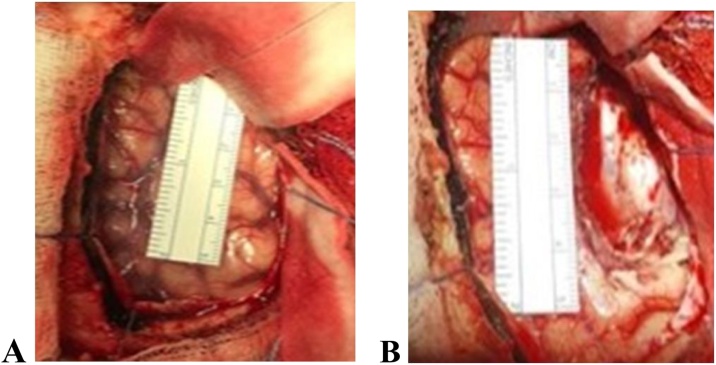
Intra-operative pictures showing the extent of neocortical dissection A. before neocortical resection and B. after neocortical resection with exposure medial temporal lobe structures.